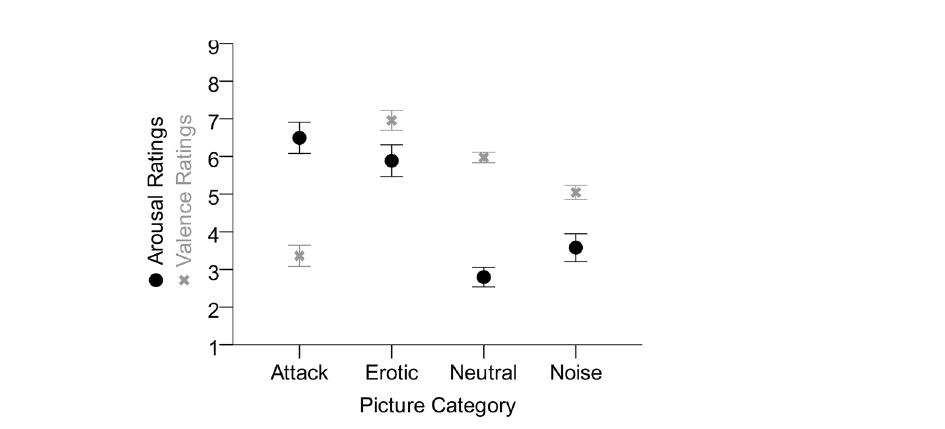
Figure 6. Mean standard deviations ( SD ) of TTC estimation errors (variable error) as a function of velocity, contrast condition (panel a), and actual TTC (panel b). Error bars represent ± 1 standard error of the mean across participants.